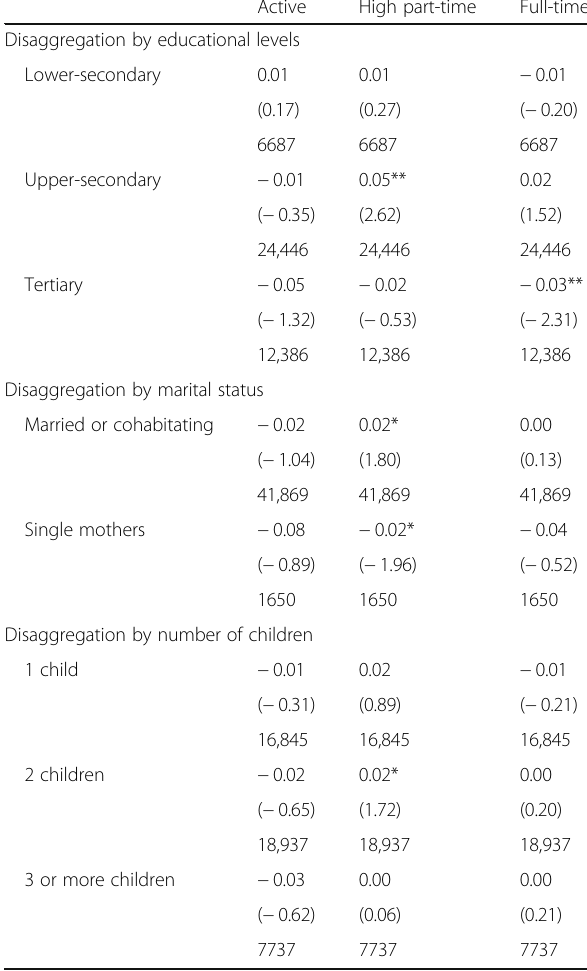
Table 4 Difference-in-differences estimates of the impact of the reform on maternal employment by different individual and household